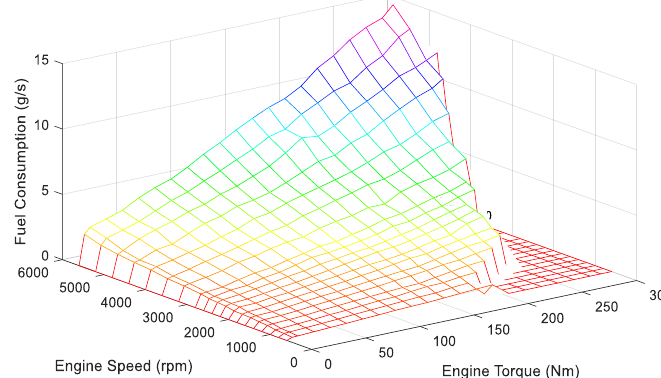
Figure 5. ICE fuel consumption rate.